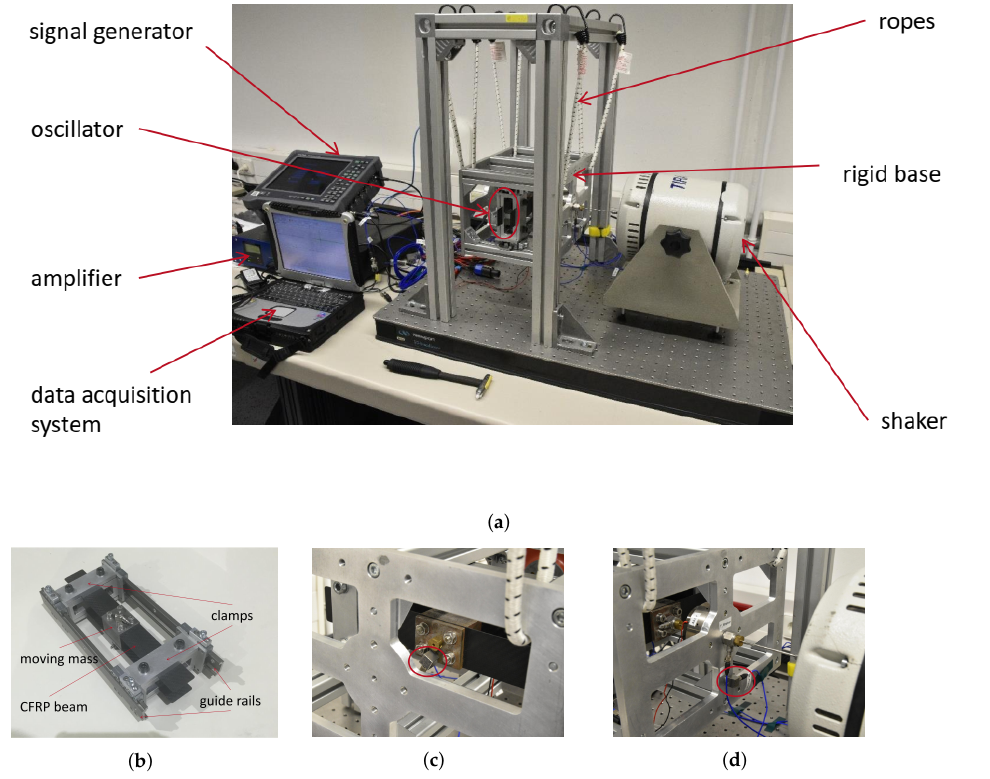
Figure 12. ( a ) Components of the test bench, ( b ) details of the oscillator, ( c ) accelerometers on the moving mass and ( d ) on the